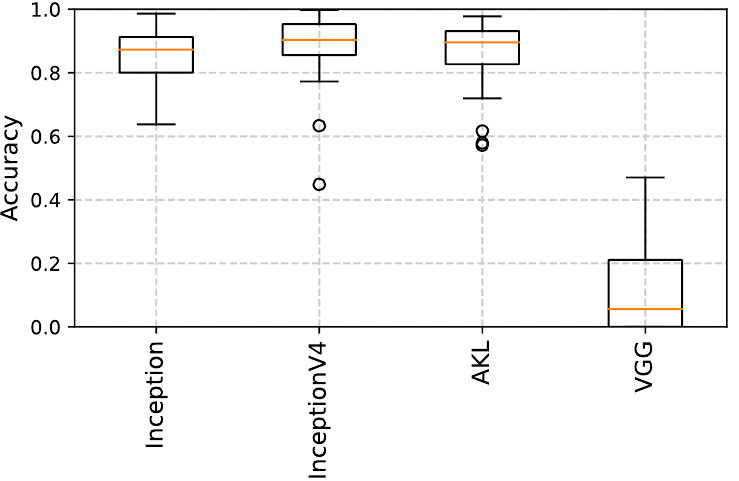
128. The 128. The × ˆ